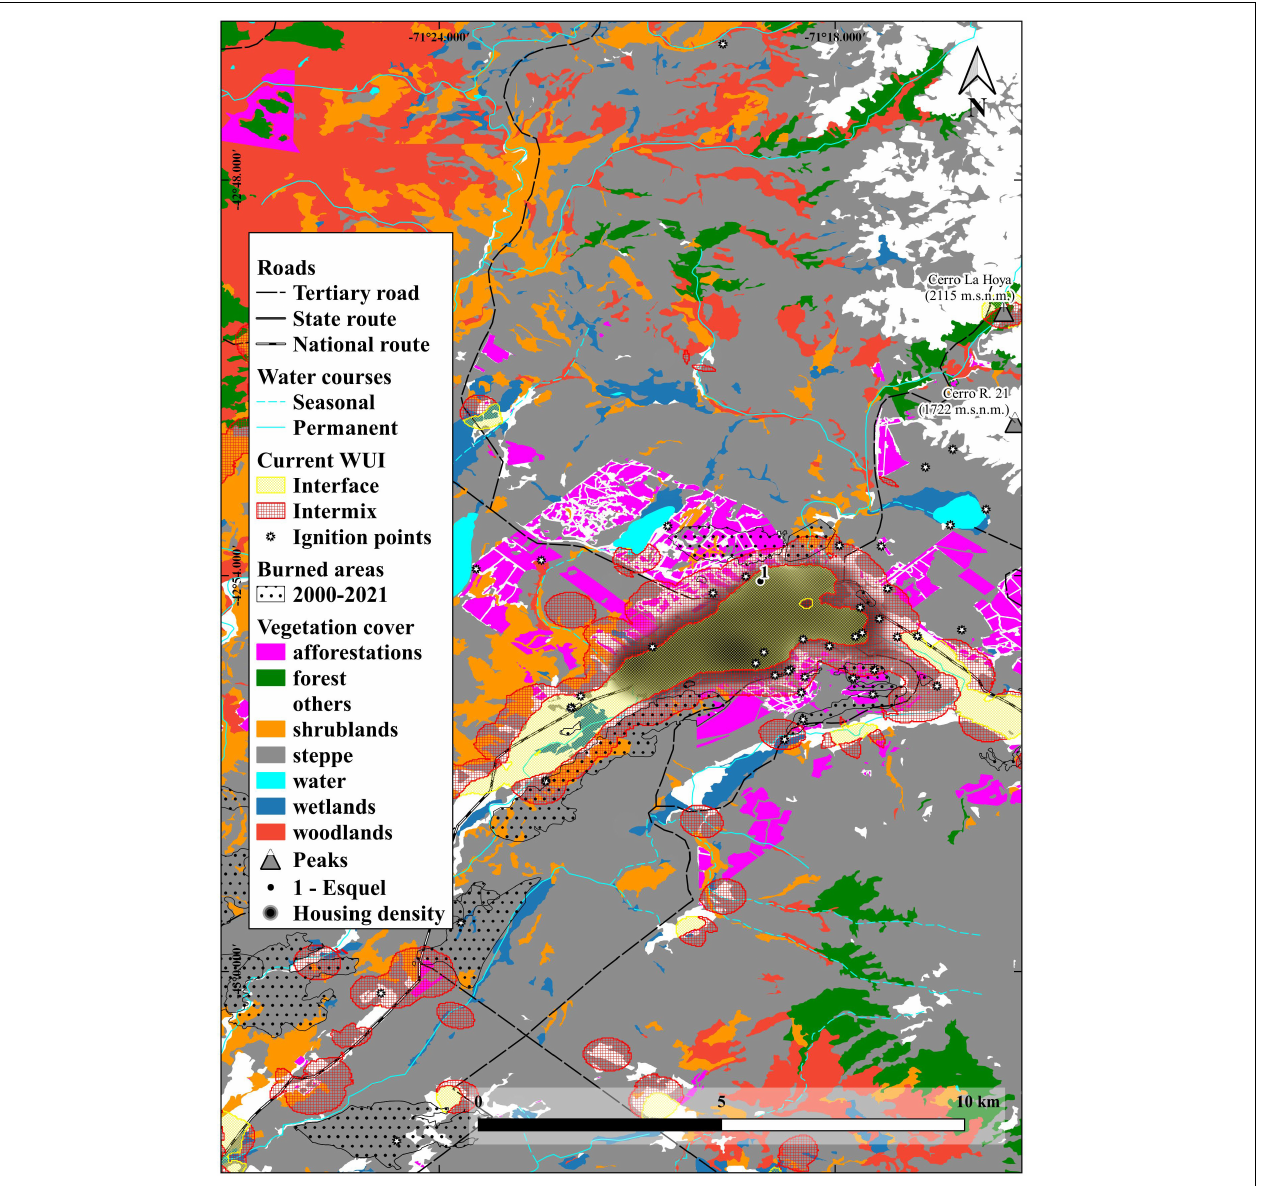
FIGURE 5 | Detail of the town of Esquel and its surroundings. The yellow lines delimits the interface zone red lines delimits the intermix zone. The dotted points indicates wildfires and the white points are the ignition points. Note that afforestations are very near of the town and most of the vegetation type is